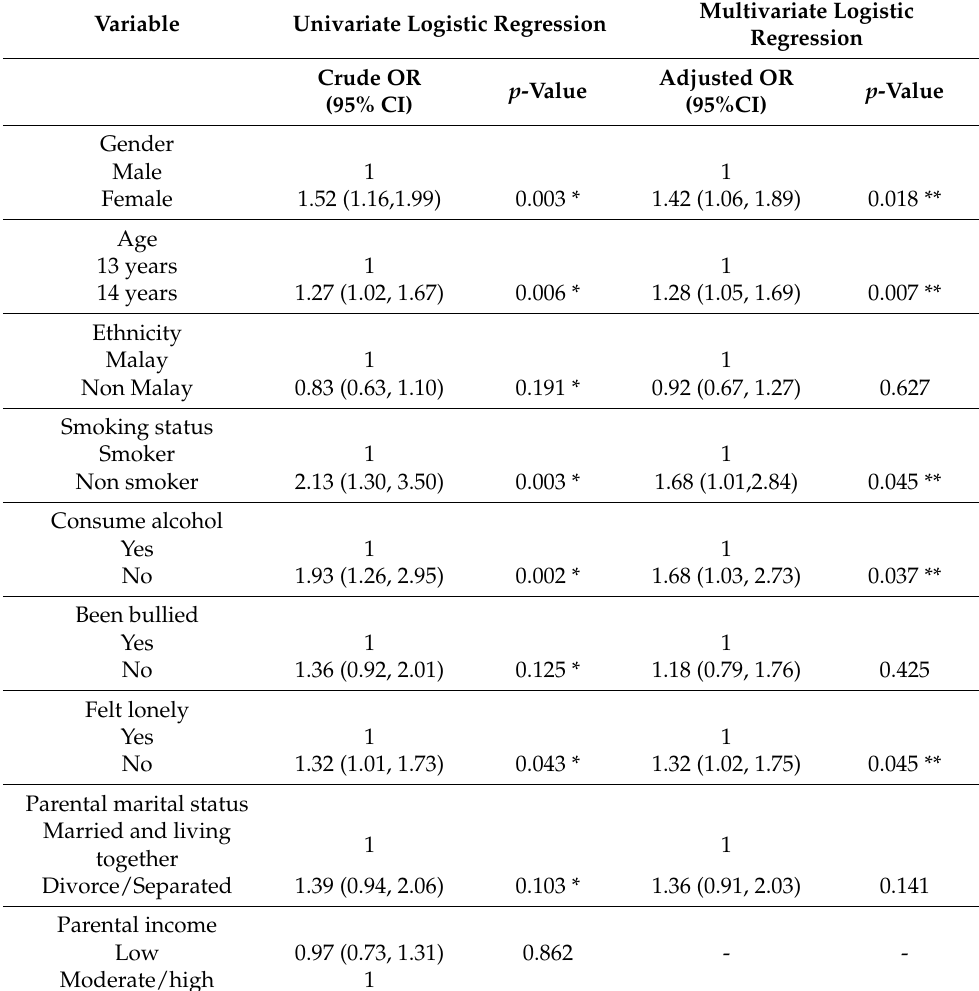
Table 3. Factors associated with intention to seek help.